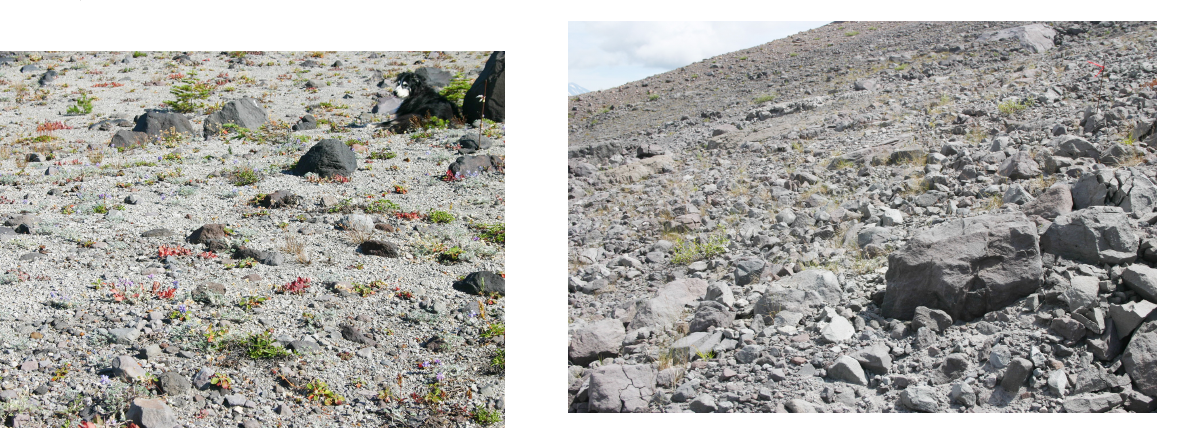
Fig. 9. Upper Studebaker Ridge, with rocky lava exposed and only a few scattered herbs (Photo: RdM